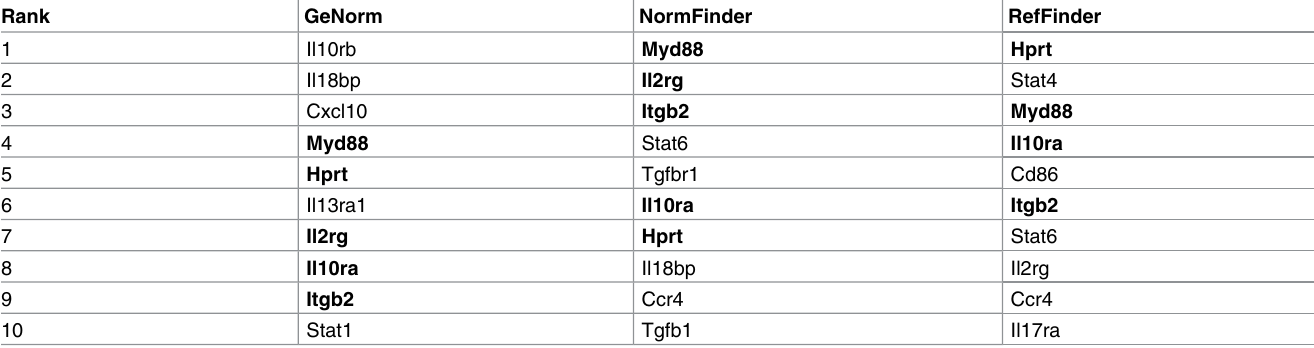
Bold letters indicate those genes that were identicalamong the top-tenby the three methods. Italics indicate “traditional”reference genes according to